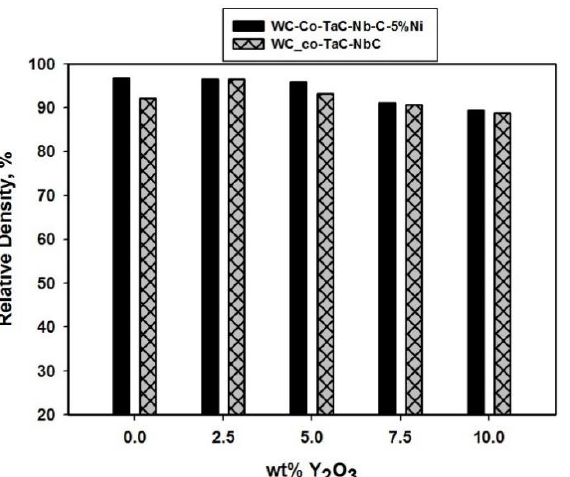
Figure 5. Relative density of the consolidated WC-Co-TaC-NbC and WC-Co-TaC-NbC-Ni-5 wt%) composites with Y 2 O 3 additions, from 0 wt% to 10 wt%.